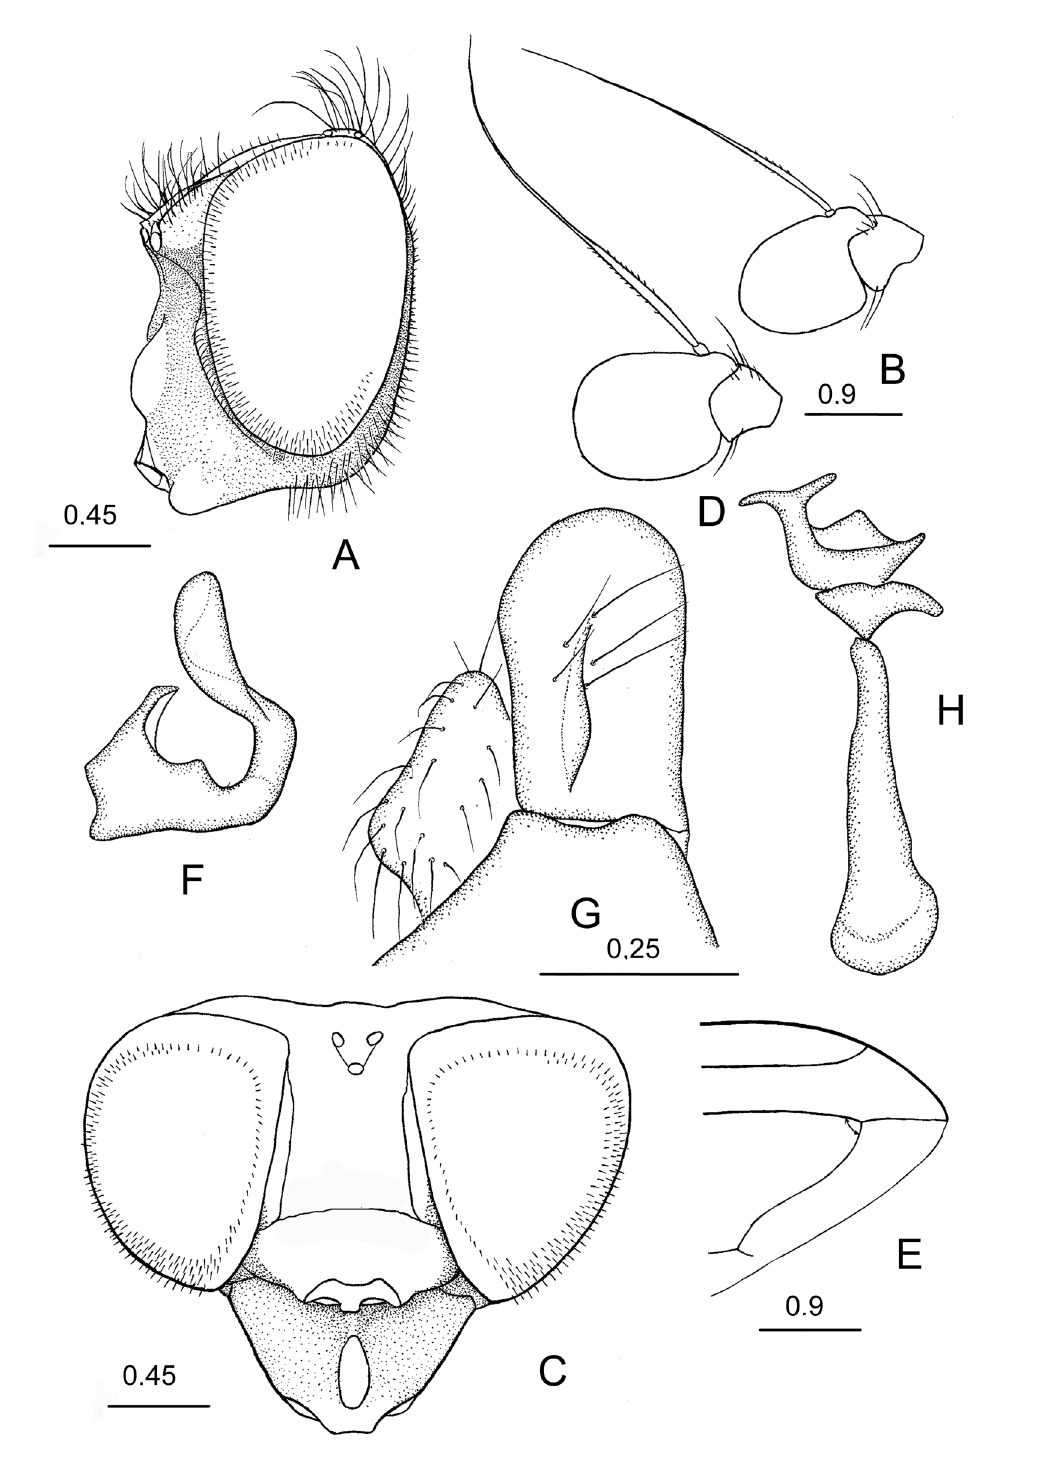
Fig. 27. Cheilosia ( Cheilosia ) hauseri sp. nov.; A–B, E–H = holotype, ♂ (CSCA), C–D = paratype, ♀ (CNC). A . Head, lateral view. B, D . Antenna, lateral view of pedicel and basoflagellomere. C . Head, dorsal view. E . Tip of wing. F . Superior lobe of hypandrium, lateral view. G . Surstylus and gonocercus, lateral view. H . Aedeagus and aedeagal apodeme, lateral view. Scale bars indicated in